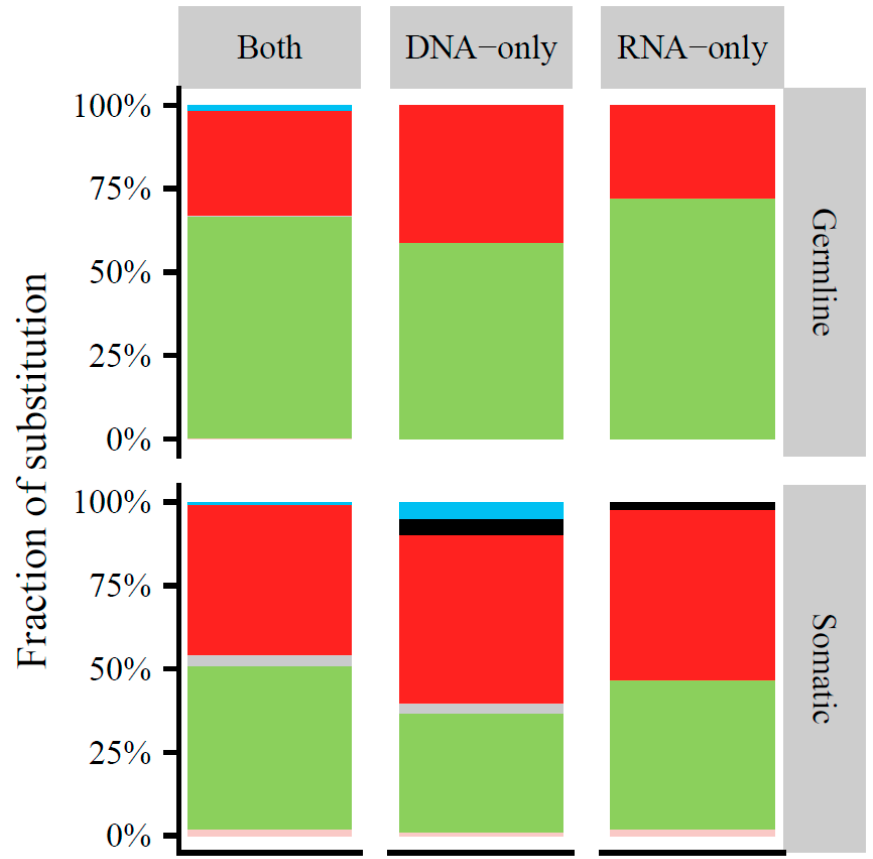
Figure A5. Somatic spectrum of mitochondrial DNA and mitochondrial RNA variants of the 165 overlapping primary breast tumor cases. The contribution of the six possible base substitutions (C > A in blue, C > G in black, C > T in red, T > A in grey, T > C in green and T > G in pink) are depicted for the germline (top) and somatic (bottom) variants detected in both (left) the DNA (middle) or the RNA (right) datasets.